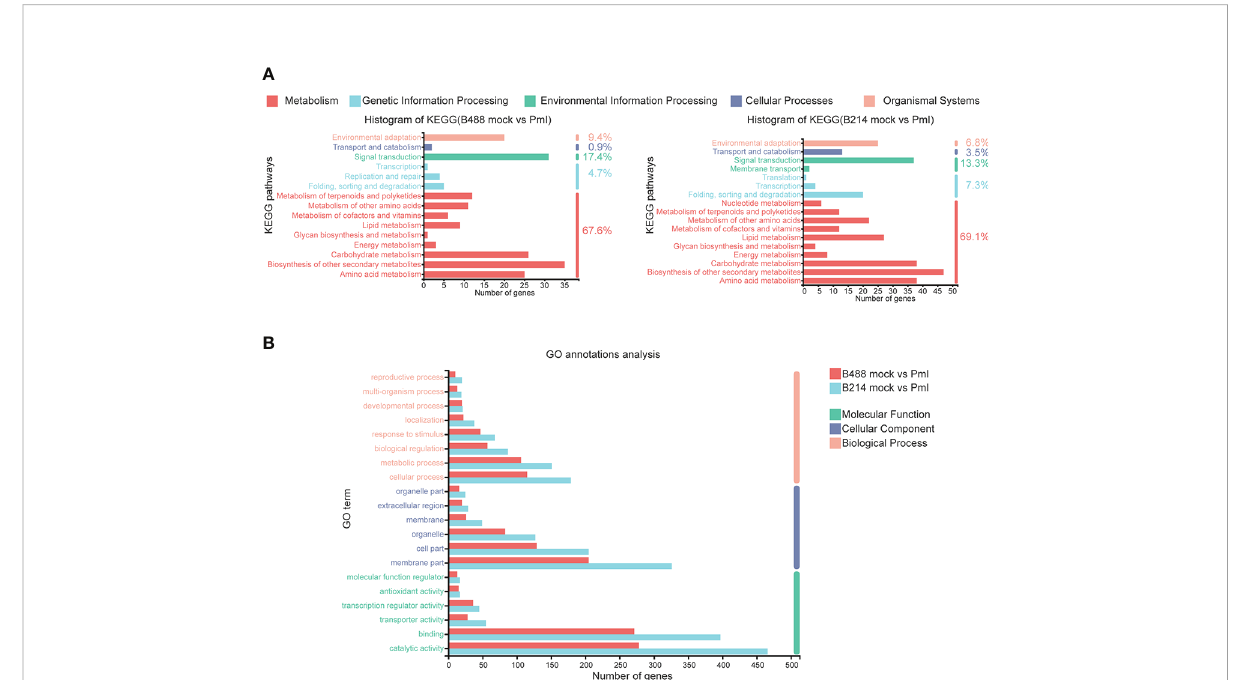
FIGURE 3 KEGG annotations analysis and GO annotations analysis of DEGs. (A) KEGG annotations analysis of the DEGs in B488 (mock infection vs. PmI) and B214 (mock infection vs. PmI), the number indicated the percent of gene enrichment in the pathway. (B) GO annotations analysis of DEGs in B488 (mock vs. PmI) and B214 (mock vs. PmI).